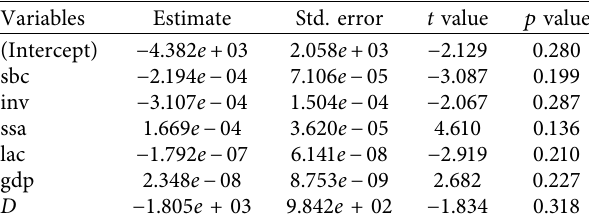
Table 6: Results of the filtered regression analysis.